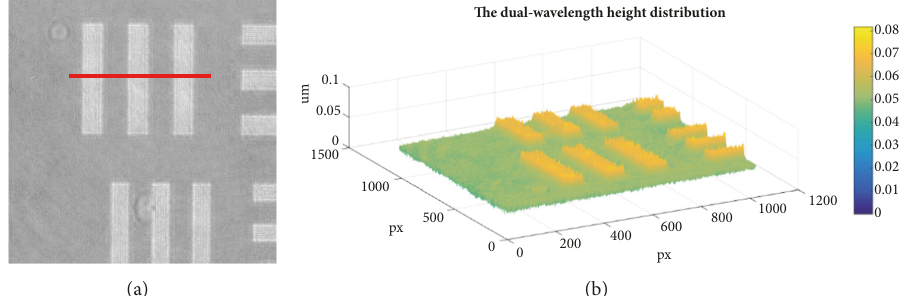
Figure 6: Experimental results for equivalent wavelength. (a) Phase image for equivalent wavelength, (b) 3D view of dual-wavelength height distribution.